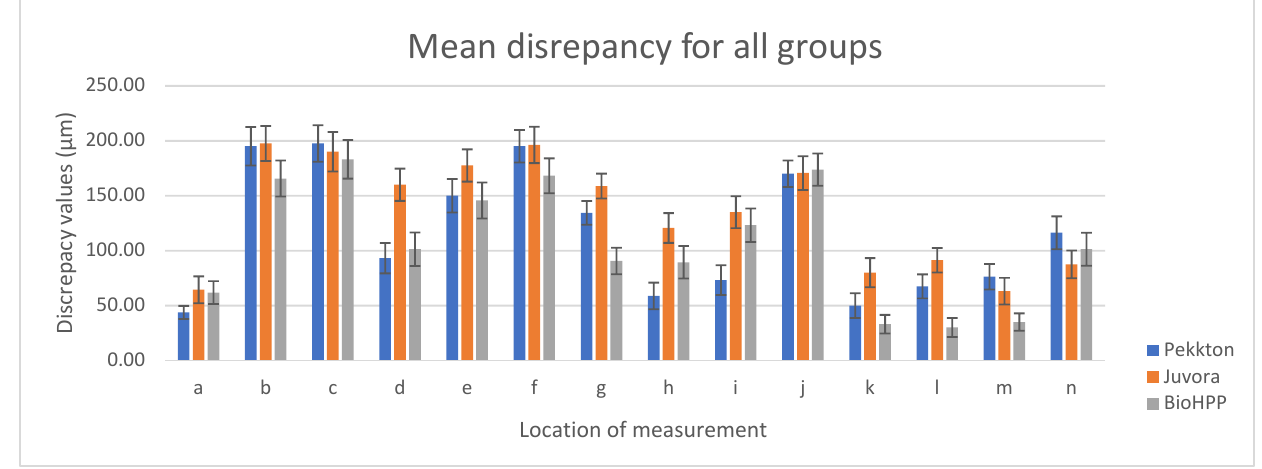
Figure 4. Average values obtained at the reference points of the both